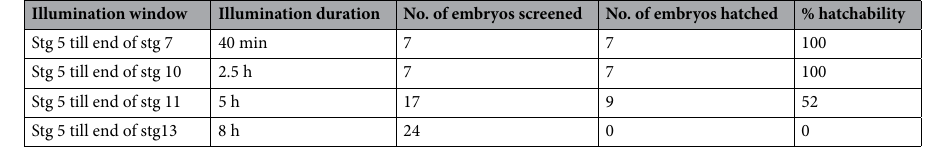
Table 3. Hatching rate of twi ::Gal4 > Opto-htl embryos illuminated during different time windows. (stg = stage).